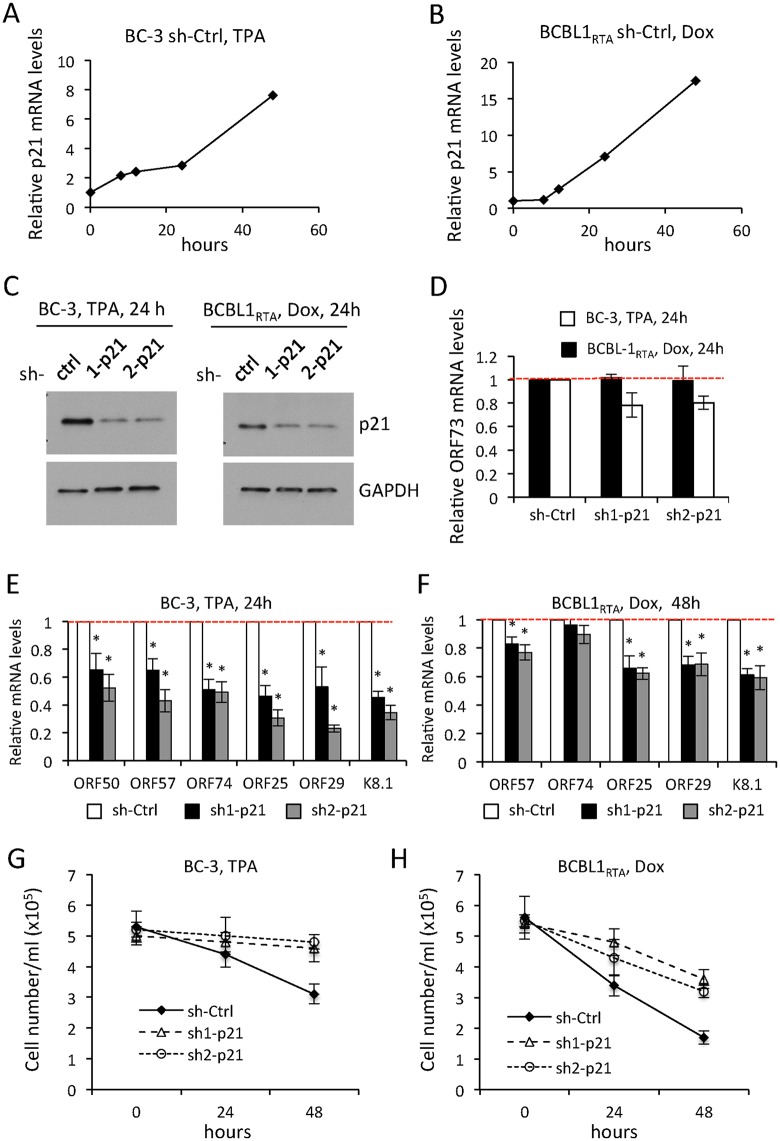
p21 depletion impairs lytic gene expression in PEL cells.(A-B) Quantification of p21 mRNA levels by qRT-PCR during a time course of TPA or doxyxyclin induced reactivation in the BC-3 and BCBL1RTA PEL cells, respectively, stably expressing non specific sh-Ctrl. (C) WB analysis of p21 levels in whole cell extracts from PEL cells stably expressing indicated shRNAs and induced to reactivation with TPA (BC-3) or Dox (BCBL1RTA) for 24 h. GAPDH was used as a loading control. (D) Quantification of ORF73 (LANA) mRNA levels by qRT-PCR in PEL treated as in (C). Values represent the average and SEM of three replicates, and are normalized to the shCtrl set to one (red dashed line). (E-F) Quantification of transcription of the indicated lytic genes in PEL cells stably expressing sh-Scr, sh1-p21 or sh2-p21 and induced by TPA for 24h (BC-3, E) or Dox for 48h (BCBL1RTA, F). The values represent the mean and SDM of three independent experiments, and are normalized to sh-Ctrl set to one (red dashed line). *p<0.05. (G-H) Quantification of cell number to monitor virus replication induced cytopathic effect in PEL cells expressing indicated shRNAs and induced to lytic reactivation by TPA (BC-3, G) or Dox (BCBL1RTA, H). The values represent the mean and SDM of three independent experiment.